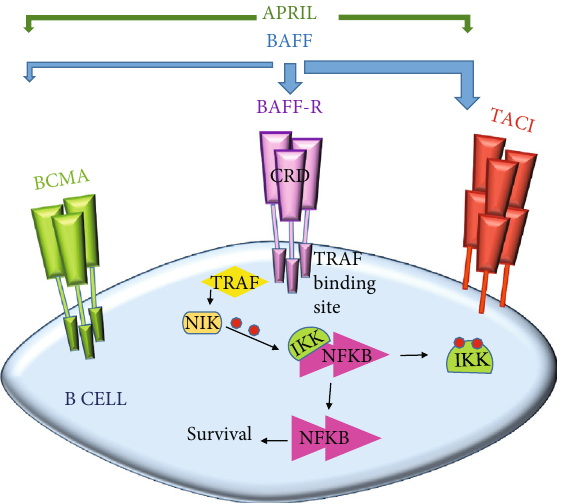
Figure 1: BAFF receptors. BAFF has three receptors on B cells, including BCMA, BAFF-R, and TACI, which usually exist in trimer form on the cell surface. APRIL is another cytokine that acts like BAFF and has two common receptors with BAFF include of BCMA and TACI. BAFF binds to its receptors with di ff erent a ffi nity. Thicker arrows show more a ffi nity of BAFF to each receptor. The extracellular domain of receptors consists of cysteine-rich domain (CRD) as ligand binding site (TACI has an extra binding site). Intracellular domains of BCMA and BAFF-R contain a TRAF binding site that initiate the signaling cascade after binding to TRAF, leading to subsequent events like cell survival. BAFF: B cell activating factor; BCMA: B cell maturation antigen; TACI: transmembrane activator and calcium-modulating cyclophilin ligand interactor; APRIL: a proliferation-inducing ligand; TRAF: TNF receptor associated factor; NF- κ B: nuclear factor- (NF-) κ B; NIK: NF- κ B inducing kinase; IKK: inhibitor of κ B kinase